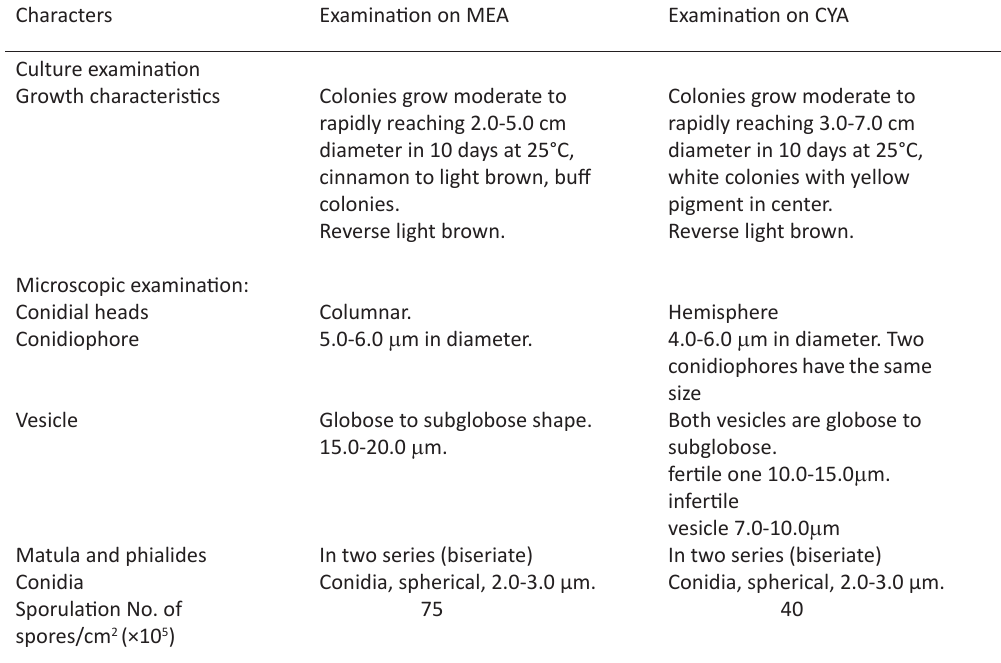
Table 1. Culture characteristics of A. terreus in two common growth media MEA and YES agar Characters Examination on MEA Examination on CYA Culture examination Growth characteristics